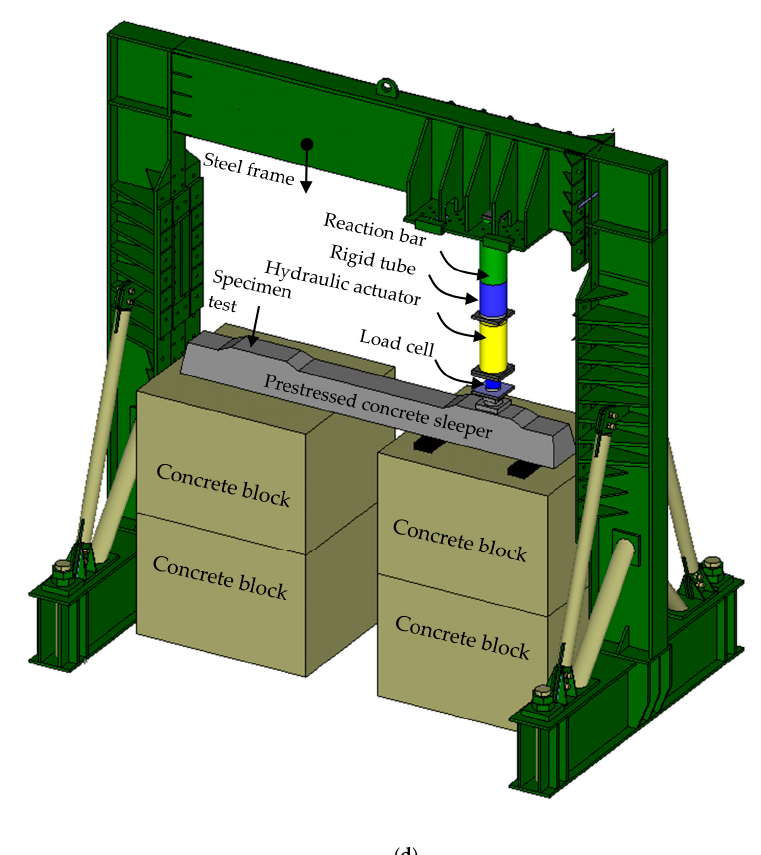
Figure 3. Experimental tests: ( a ) detail of positive moment test at midspan; ( b ) detail of positive moment test at the support; ( c ) positive moment test at midspan-schematic model in INFRALAB Laboratory; and ( d ) positive moment test at the support-schematic model in Structures Laboratory—LABEST.